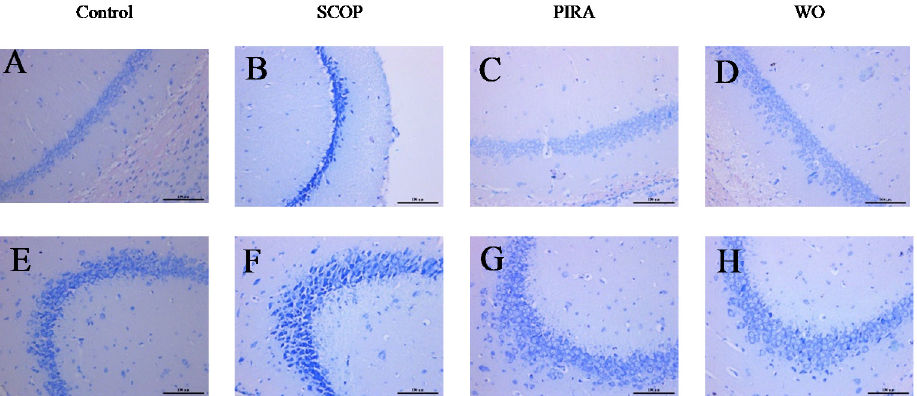
Figure 4. Effects of walnut oil on the result of Nissl staining of hippocampal CA1 ( A – D ) and CA3 ( E – H ) regions of brains of mice. Histological sections of the brain tissue showing neurological lesions ( A – H ). Scale bar is 100 µm.